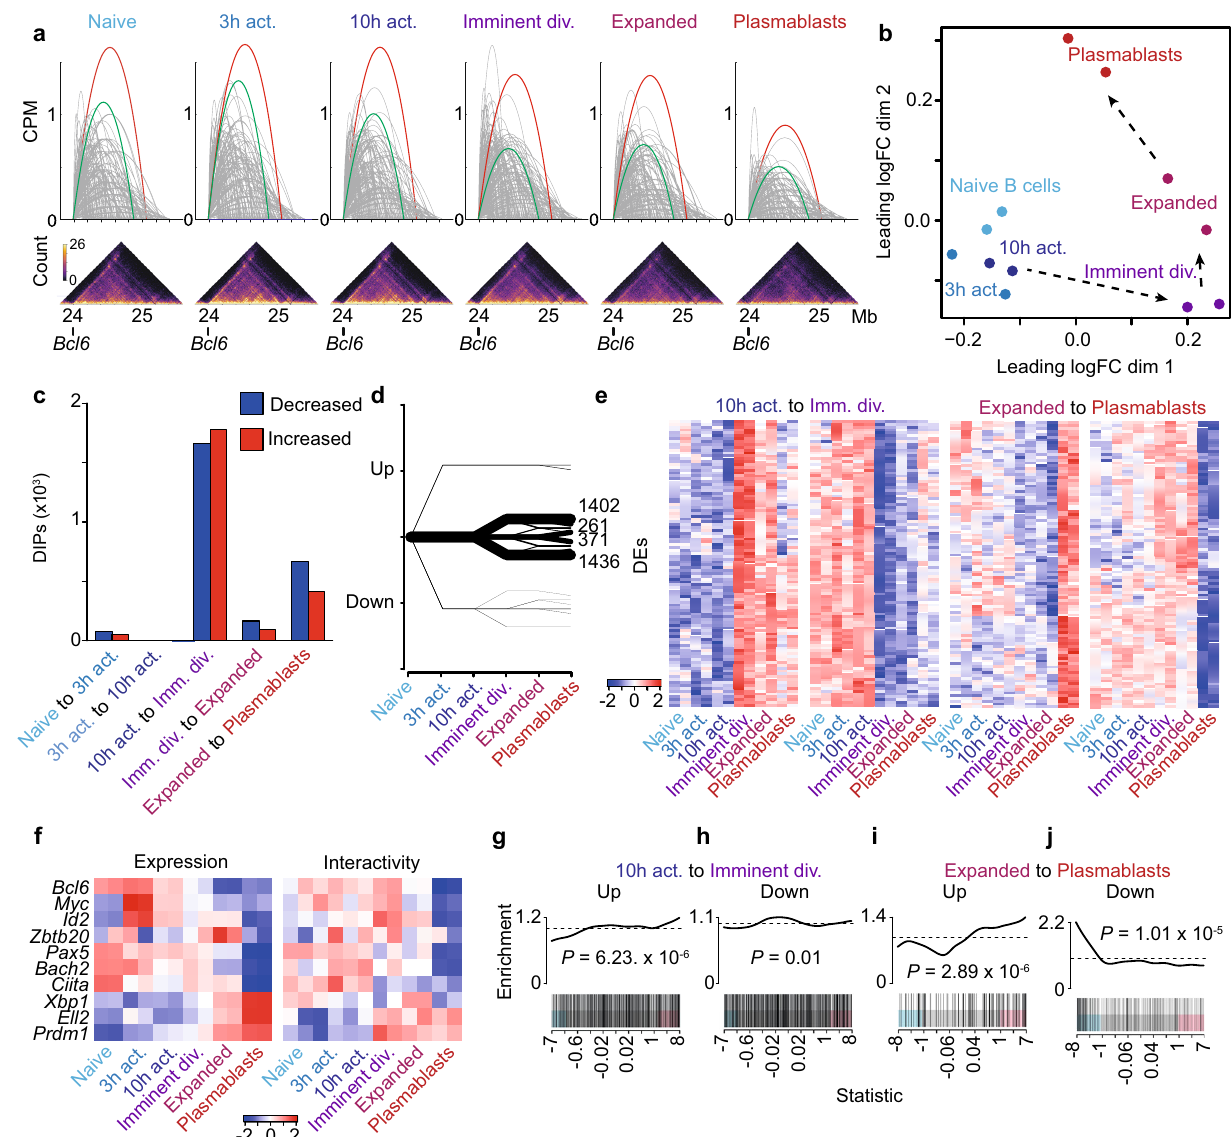
Fig. 3 Gene promoter interactivity reveals a direct link between reorganization and transcription. a Schematic showing how a promoter interaction count is determined. Each interaction with the Bcl6 promoter is shown as an arc. The sum of these interactions in counts per million (CPM) is the promoter interaction count. The red and green arcs show select interactions that represent dominant looping interactions. Below are the corresponding raw in situ contact matrices (10 kbp resolution). Color scale indicates the number of reads per interaction. b Multidimensional-scaling plot of the fi ltered and normalized logCPM values for interacting promoters during B-cell activation. c Bar plot showing the number of differentially interacting promoters (DIPs) between each transition of B-cell activation. Blue indicates decreased interactivity. Red indicates increased interactivity. d Plot showing the patterns of change and numbers of DIPs during B-cell activation. Line thickness represents the number of DIPs in each pattern. e Heatmap of logCPM of the top 100 DIPs by false discovery rate in patterns of change in DIPs. The patterns shown represent the two dominant waves of organizational change, either exclusively increasing or decreasing at the 10 h activation to imminent division transition or the expanded to plasmablasts transition. f Heatmaps showing a change in expression (logRPKM) and change in promoter interactions (logCPM) in key B-cell differentiation genes across B-cell activation. g Barcode enrichment plot showing the correlation between promoters that signi fi cantly increase in promoter interactions as B cells prepare to divide (10 h activation to imminent division) with increases in gene expression at the same transition (Fig. 1). Genes are ordered on the plot from right to left ( x axis) from most upregulated to most downregulated according to the moderated F -statistic. p -value was calculated with the fry test. h Barcode enrichment plot showing the correlation between promoters that signi fi cantly decrease in promoter interactions as B cells prepare to divide (10 h activation to imminent division) with decreases in gene expression at the same transition (Fig. 1). Genes are ordered on the plot from right to left ( x axis) from most upregulated to most downregulated according to the moderated F -statistic. p -value was calculated with the fry test. i Barcode enrichment plot showing the correlation between promoters that signi fi cantly increase in promoter interactions as B cells differentiate into plasmablasts (expanded to plasmablast) with increases in gene expression at the same transition (Fig. 1). Genes are ordered on the plot from right to left ( x axis) from most upregulated to most downregulated according to the moderated F -statistic. p -value was calculated with the fry test. j Barcode enrichment plot showing the correlation between promoters that signi fi cantly decrease in promoter interactions as B cells differentiate into plasmablasts (expanded to plasmablast) with decreases in gene expression at the same transition (Fig. 1). Genes are ordered on the plot from right to left ( x axis) from most upregulated to most downregulated according to the moderated F -statistic. p -value was calculated with the fry test. Source data are provided as a Source Data fi